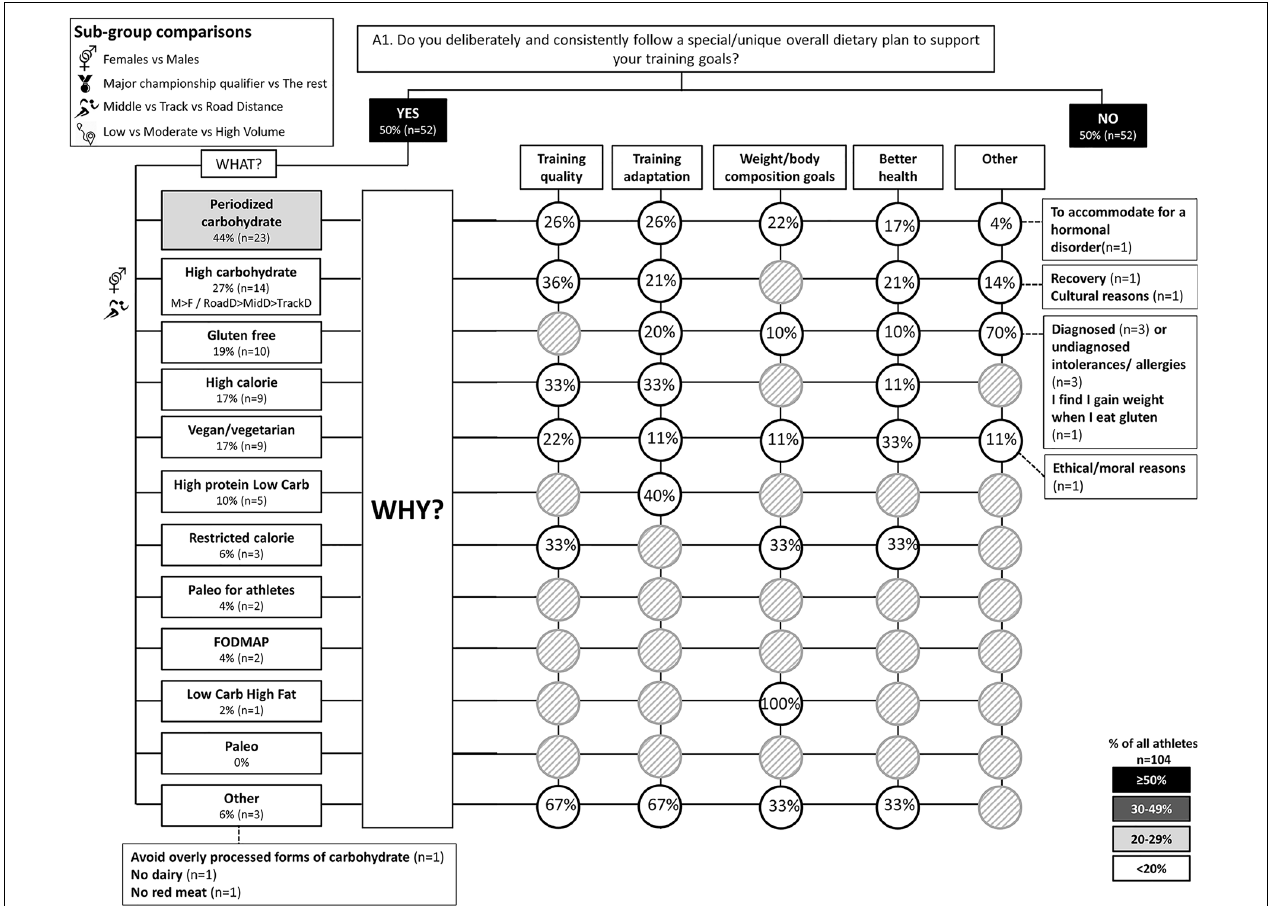
FIGURE 1 | A1: Overall dietary practices across the year. The prevalence of specific, consistent nutrition practices (e.g., vegetarian) and the reasons for following them in 104 elite female and male track and field endurance athletes. Percentages ( % ) reflect the % of athletes that chose a specific answer in relation to all athletes (YES/NO answers) or in relation to specific sub-question populations (i.e., % of those that answered YES or NO). In addition, number (n) of athletes per each answer box has been provided. Answer boxes or circles are color coded based on % of all athletes as follows: ≥ 50%, black box with white font ; 30–49%, dark gray box with white font ; 20–29%, light gray box with black font ; < 20%, white box with black font . Light gray circles with diagonal stripes indicate zero responses to this option. Symbols have been used to reflect significant ( p < 0.05) between-group differences between sexes ( vector sex symbol ), athlete caliber ( medal symbol ), distance event ( runner symbol ), and reported volume during base training ( distance symbol ). Where significant differences were detected, answer boxes include a brief description of direction of difference, for example, M > F reflects a higher % of males (M) compared to females (F) for that answer. MidD , Middle Distance (800 and 1500 m); TrackD, track distance (3000 m steeplechase to 10,000 m); RoadD , road distance (marathon and race walks). High caliber, major championship qualifiers; Lower caliber, those that have not qualified to major championships. Low, Moderate, and High Volume groups as sex-specific tertile cut-offs.